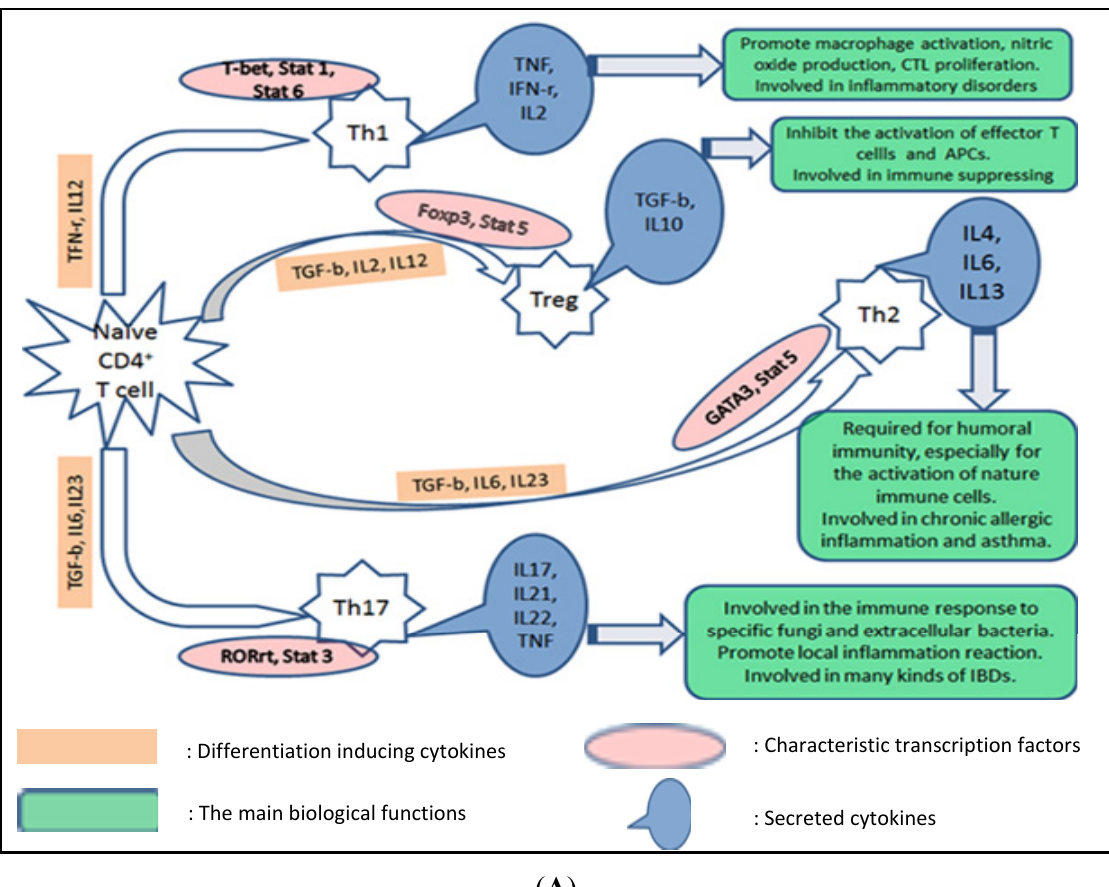
Figure 1. Diagram of CD4 T cell differentiation and immunomodulation by the AhR signaling pathway. ( A ) Summary of the major sets of CD4 T cells, including critical differentiation factors for fate determination, characteristic transcription factors, their unique products and some of their functions; ( B ) AhR signaling pathway involved in the differentiation of CD4 helper T cell subsets. Immune homeostasis in mammals is precisely controlled by internal humoral factors and neuro-regulation. When disturbed by environmental and physiological factors or by pathogens, homeostasis will be destroyed, and the resulting immune imbalance promotes inflammatory autoimmune diseases. The AhR signaling pathway can promote Treg cell differentiation, decrease effector T cells, especially the Th17 cell subset, directly or indirectly and in a ligand-specific